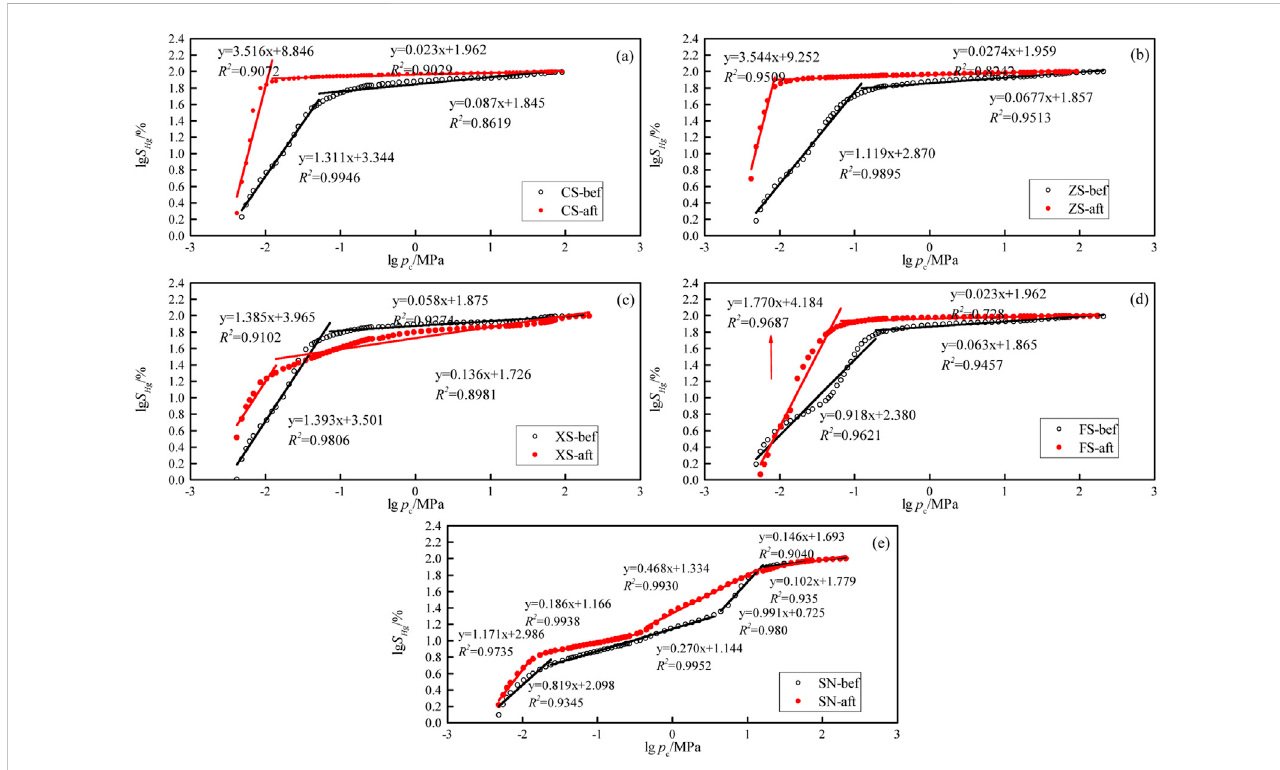
FIGURE 8 The relationship between lg S Hg and lg p c of samples. (A – E) represent the samples CS, ZS, XS, FS, and SN.